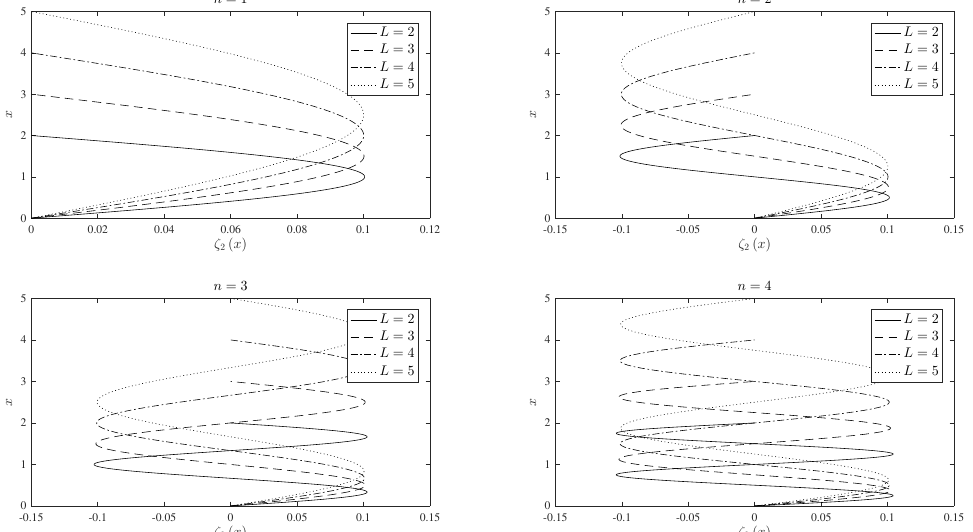
Figure 15. Different mode shapes of the buckled elastic pinned beam for the four lowest buckling forces, n = 1, . . . ,4, as functions of the length L of the beam. The indeterminate constant is set as b =